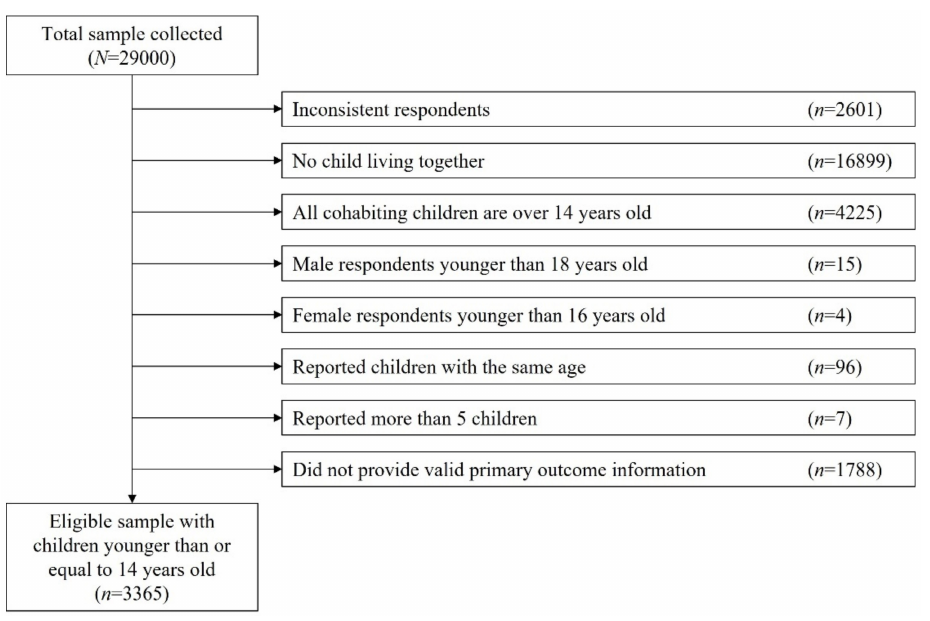
Figure 1. Flow chart of the study population.